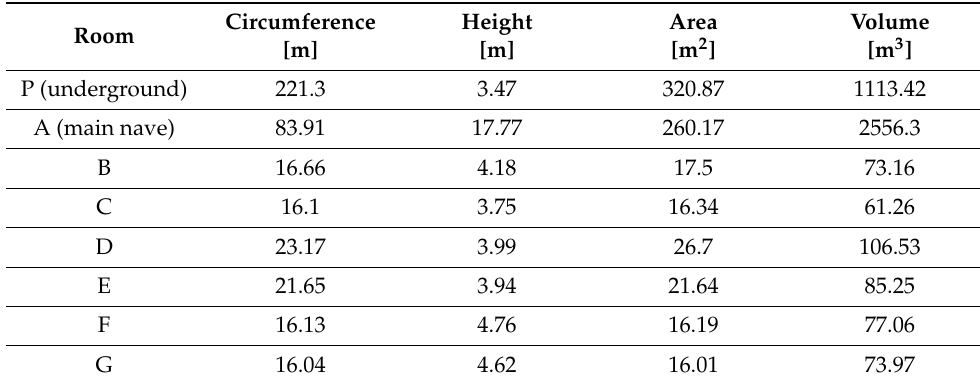
Figure 7. Points used to measure the built-up area, volume, and height of room D (on the right— hypsometric legend of relative height of objects (m)). Table 1 . Geometric characteristics of the rooms of the church .